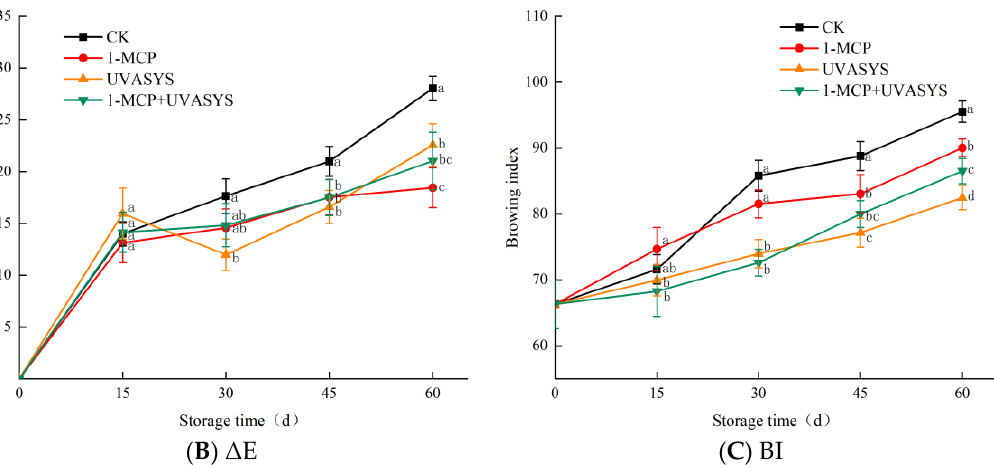
Figure 3. Effects of 1-MCP and UVASYS treatment on bamboo shoots during storage: A comparison of changes in shoots with different treatments and storage periods ( A ), ΔE ( B ), and browning Index ( C ). Each data point represents an average ± standard error ( n = 10). Different letters indicate significant differences among treatments for each sampling time at p < 0.05.